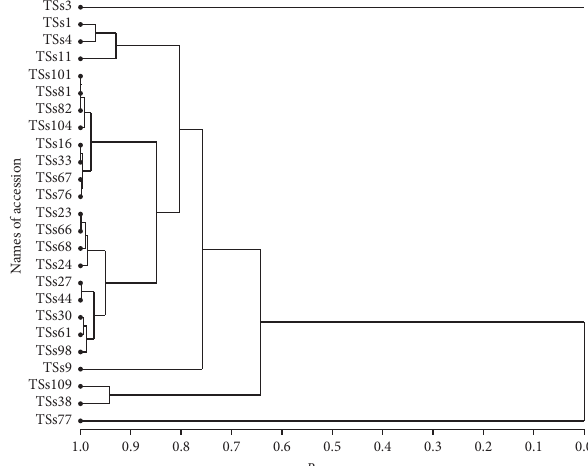
Figure 3: Multivariate analysis based on antinutrient contents of processed samples. PCA: principal component axis; TSs: Tropical Sphenostylis stenocarpa .